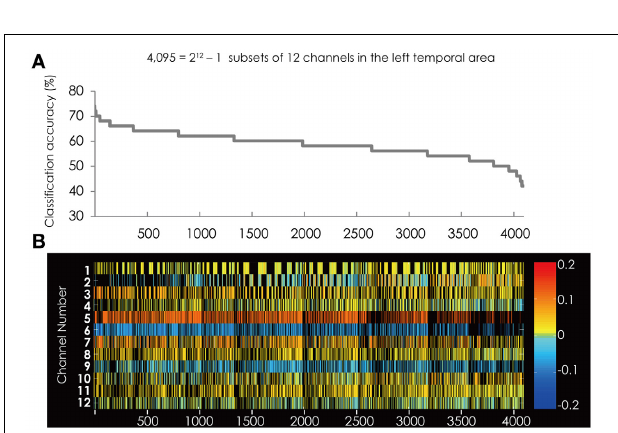
Ch. 3, 5, and 7 are red and only Ch. 6 is blue. This tendency